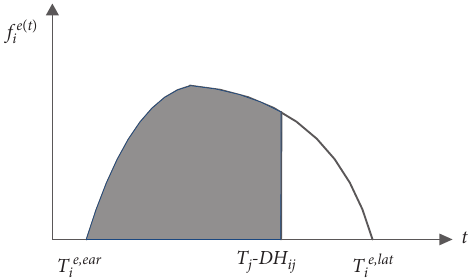
Figure 5: Compatibility probability of any two trips i and j (Figure 5 is reproduced from [19].).